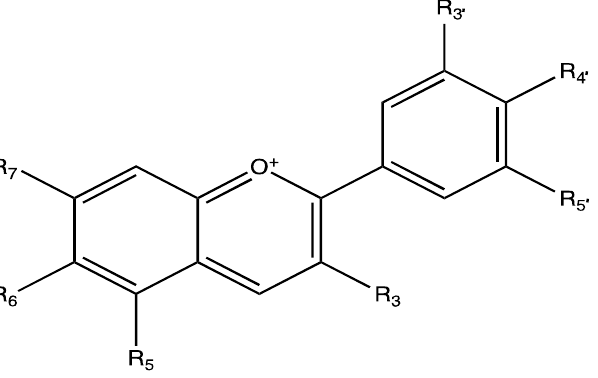
Figure 6. Basic structure of anthocyanins (flavylium cation).